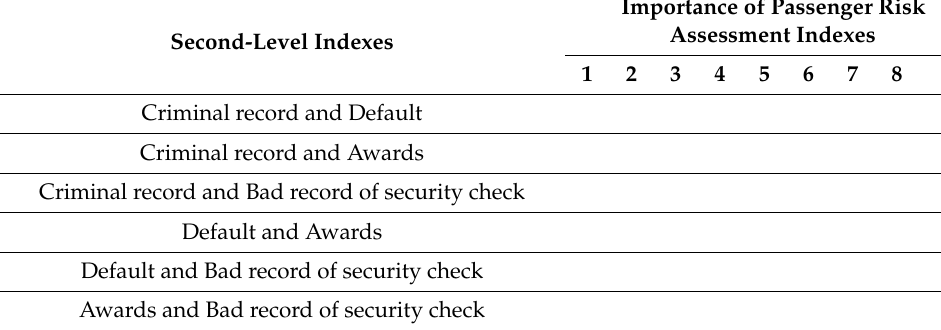
Table A5. Second-level indexes (personal conduct).